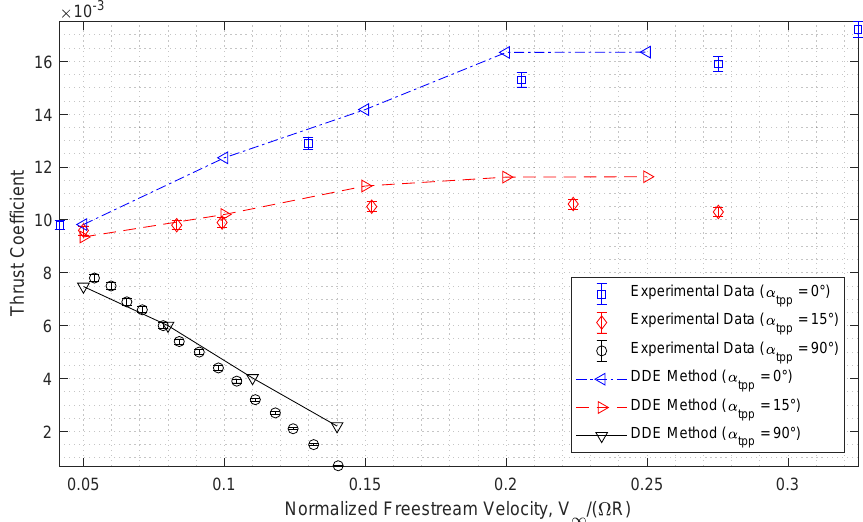
Figure 9. Comparison of time-averaged thrust forces for various advance ratios and angles of attack. The transient results of the DDE-based method were evaluated by comparing them to the single-rotor CFD simulation prediction presented by Misiorowski et al. [5], which uses a Navier–Stokes solver with a detached-eddy simulation model. An APC 12x5.5MR rotor was evaluated at a tip-path plane angle of attack of α tpp = 5 ◦ and a normalized freestream velocity of µ ∞ = 0.162, in accordance with the geometry and operating conditions specified by Misiorowski et al. [5]. The results are shown in Figure 10, which displays the sectional thrust coefficient of a single blade of the rotor, d C T /d ( r / R ) , which was determined using Equation (4), and differentiating with the non-dimensionalized spans of the sections. When discussing azimuthal location in this study, the angles ψ = 0 ◦ and ψ = 180 ◦ correspond to the rotor blades being oriented parallel to the projection of the freestream vector onto the rotor plane, as shown in Figure 10. The blade beginning in the downstream-oriented position at ψ = 0 ◦ is advancing through azimuthal locations ψ = 0 180 ◦ and retreating − through ψ = 180 360 ◦ . The opposite is true of the other blade. − Both the CFD and DDE method predictions show equivalent minimum and maximum sectional thrust coefficients of approximately 0 and 0.021, respectively. The maximum sectional thrust occurs at approximately 0.75 r / R in approximately the same azimuthal location of approximately ψ = 120 ◦ . Despite some minor differences on the retreating side where very low thrust coefficients are observed, the highly-unsteady DDE and CFD predictions agree quite well in